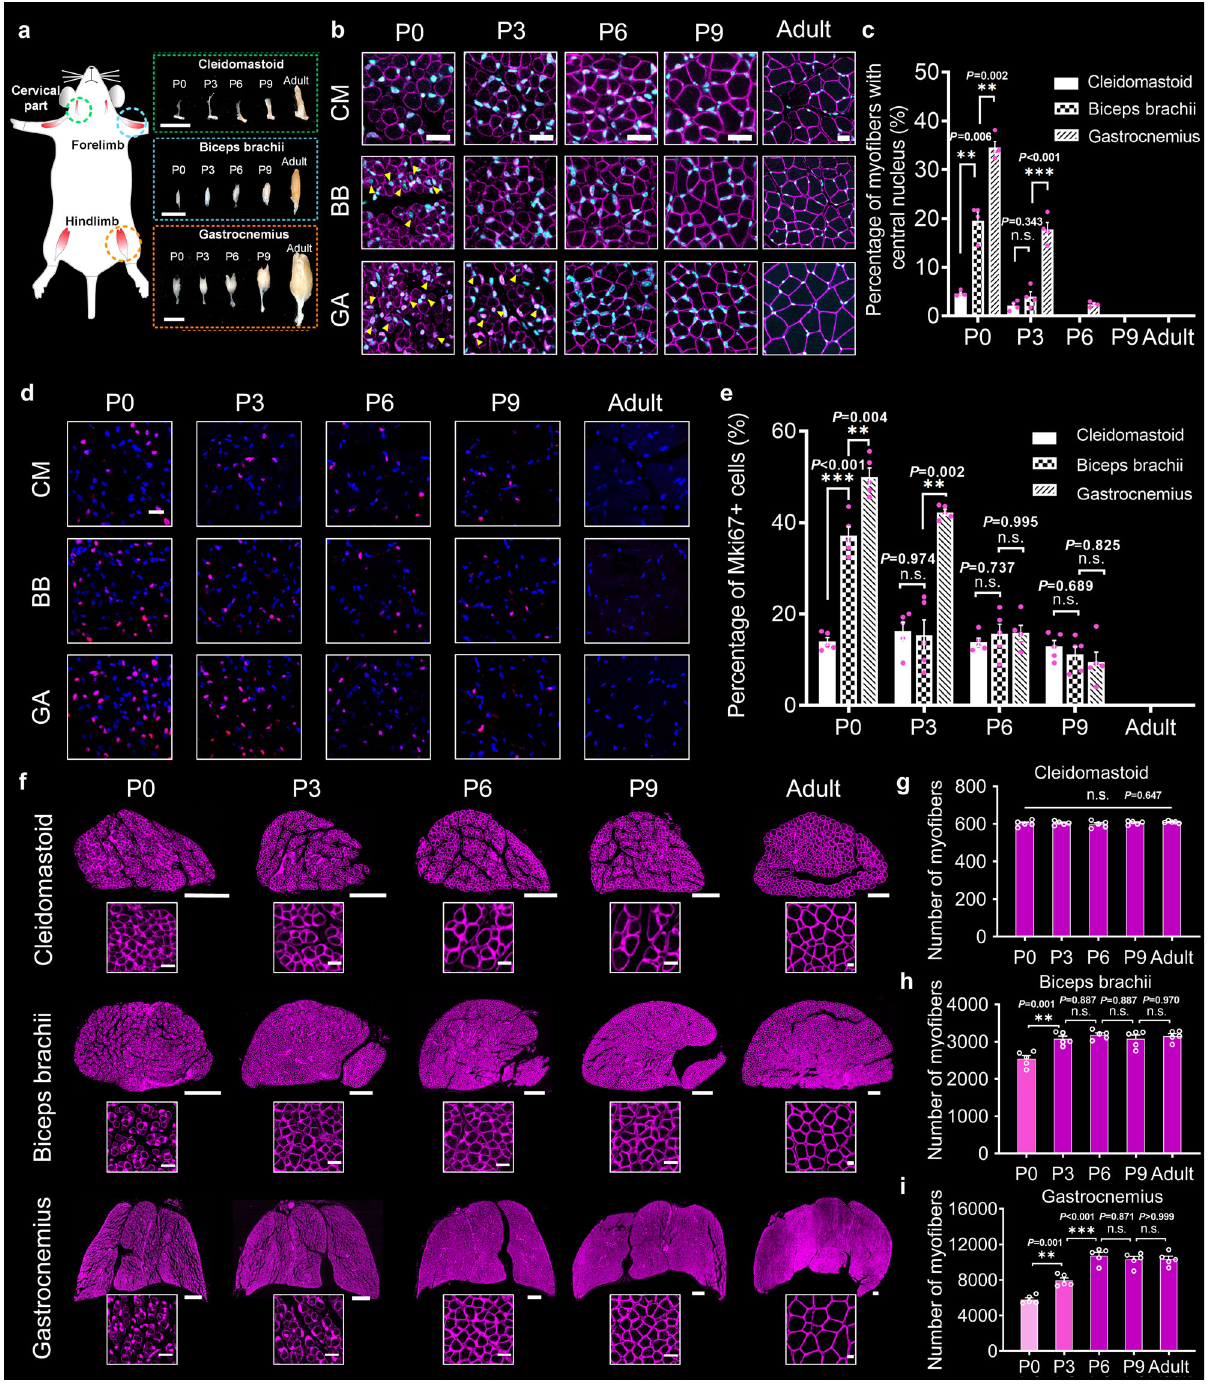
Fig. 2 Postnatal development of myo fi bers in different skeletal muscles. a The selection of muscles from different body parts, including the cleidomastoid (CM) in the cervical part, the biceps brachii (BB) in the forelimb, and the gastrocnemius (GA) in the hindlimb. Scale bar: 5 mm. b Fluorescence imaging of the location of myonuclei (cyan) relative to the membrane (magenta) in the cross-sections of different muscles after birth. The yellow arrowheads indicate myonuclei located at the center of myo fi bers. Scale bar: 25 μ m. c The quanti fi cation of the percentage of myo fi bers with central nuclei in b ( n = 4 independent animals for each muscle at each time point). d Fluorescence imaging of proliferative cells (magenta) in the cross-sections. Scale bar: 25 μ m. e The quanti fi cation of the percentage of KI67 + cells in d ( n = 5 independent animals for each muscle at each time point). f Fluorescence imaging of myo fi ber membranes in the cross-sections; scale bar: 200 μ m. The images in the white frames show the detailed morphologies of myo fi bers; scale bar: 25 μ m. g – i The quanti fi cation of myo fi ber numbers in the cleidomastoid ( g ), biceps brachii ( h ), and gastrocnemius ( i ) ( n = 5 independent animals for each muscle at each time point). All values are presented as the means ± SEM; statistical signi fi cance in c and e (n.s. represents not signi fi cant, **P < 0.01, and ***P < 0.001) was assessed using two-way ANOVA followed by Tukey post hoc test; statistical signi fi cance in g – i ( **P < 0.01 and ***P < 0.001) was assessed using one-way ANOVA followed by Tukey post hoc